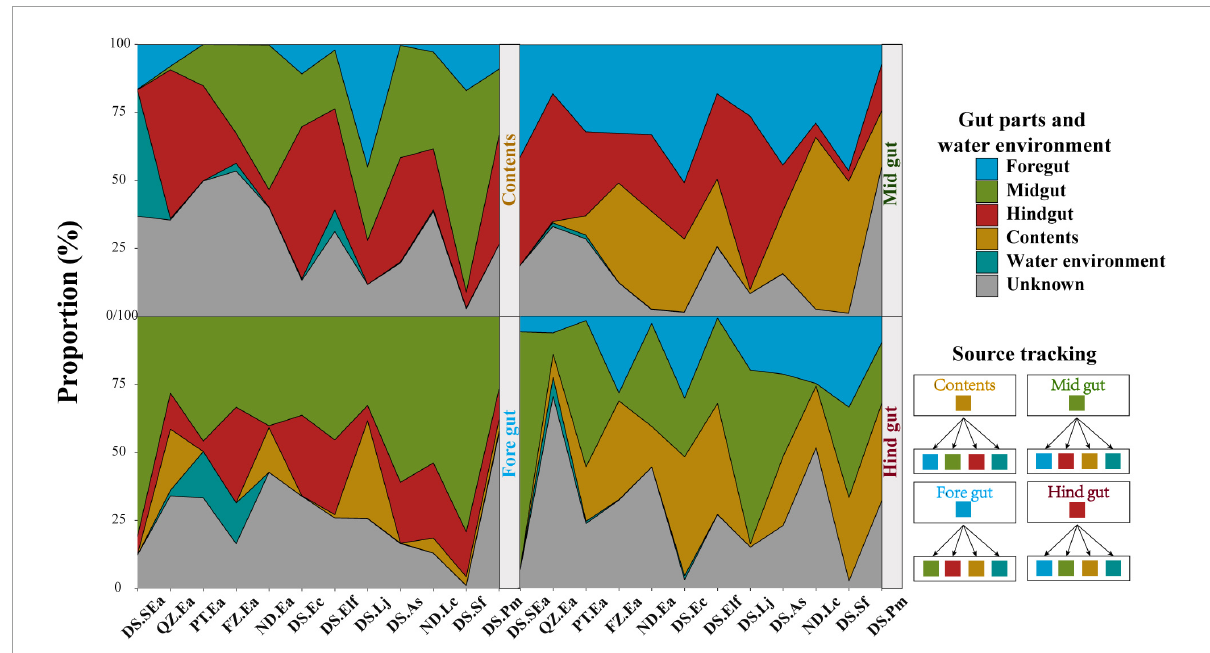
FIGURE5 Tracing the source of gut parts in each gut part and water environment. Each gut part and water environment were taken as potential sources of other gut parts. The bands of each color indicate each